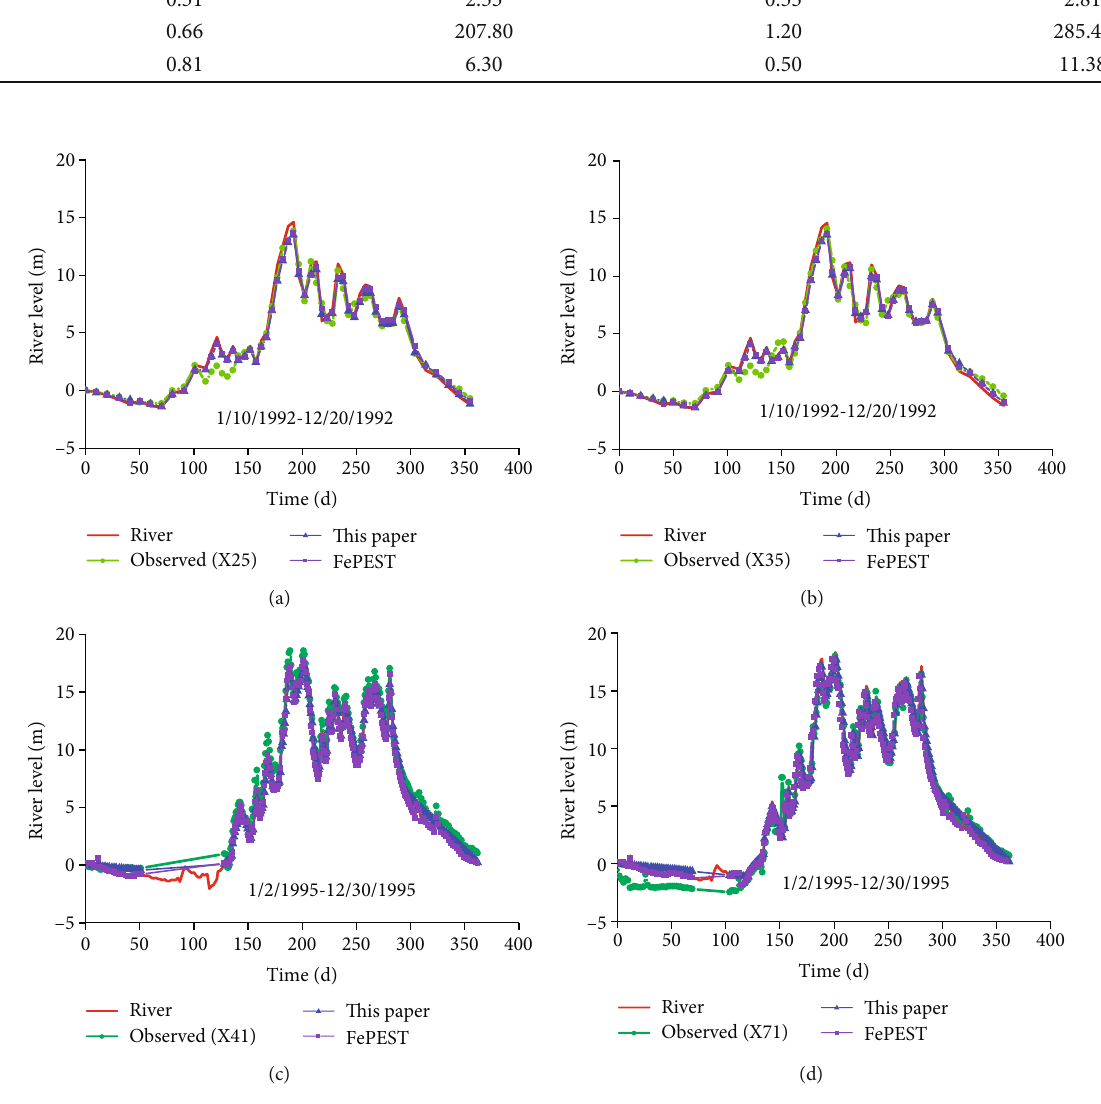
Figure 8: Observed and calculated water level fl uctuations in